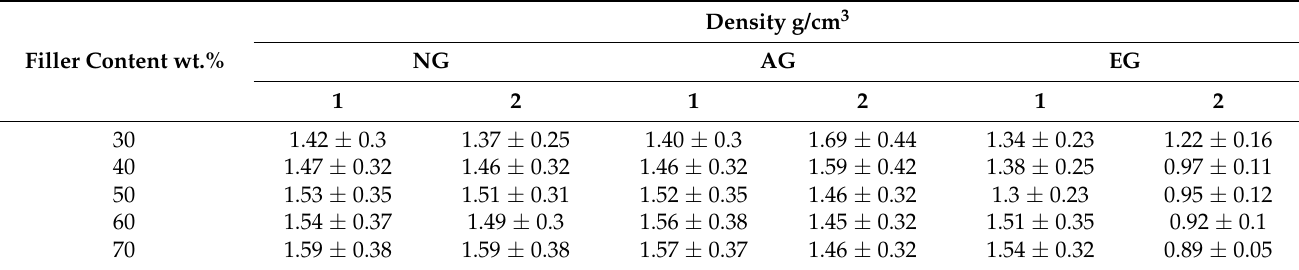
Table 2. Density of PSU based composites filled with NG, AG and EG.